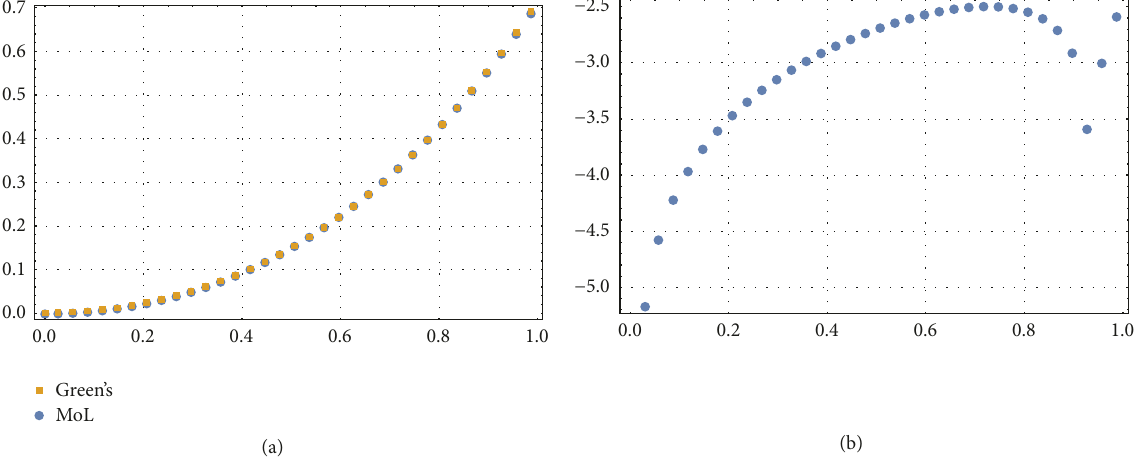
Figure 4: Discrete plot of 𝑤 and 𝑤 MoL (a) and Er (b) against 𝑡 ∈ [0, 1] for 𝑓(𝑡) = exp (𝑡) : quadratic potential. Green’s